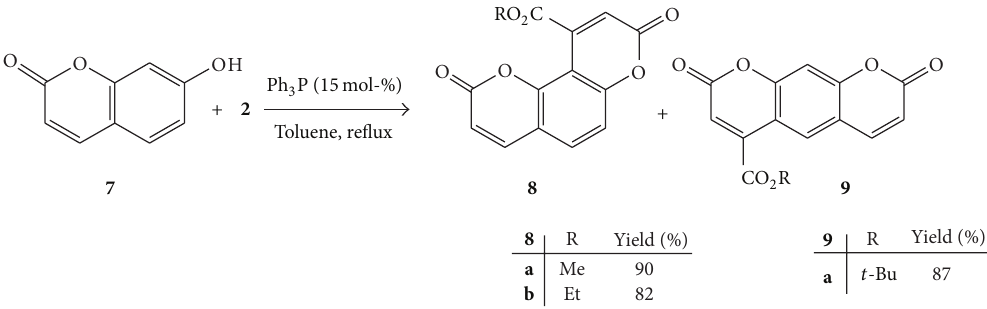
Scheme 3: Procedure for synthesis of compounds 8, 9